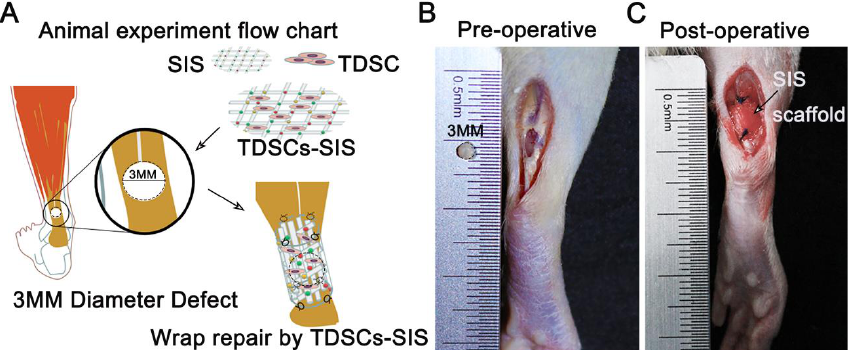
Figure 3. An animal model of repairing Achilles tendon defects with TDSCs – SIS scaffolds. ( A ) The Achilles tendon defects repaired by TDSCs – SIS scaffolds of animal experiment flow chart. ( B ) A special hole punch was used for modeling Achilles tendon defects with a diameter of 3 mm. ( C ) Immediate postoperative image of the repair of Achilles tendon defect with TDSCs – SIS scaffolds.